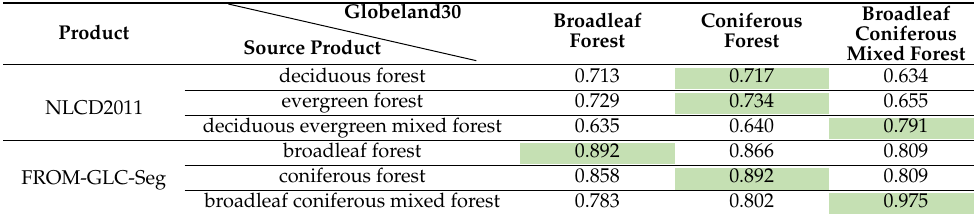
Table 6. Results of mapping based on attributes similarity.